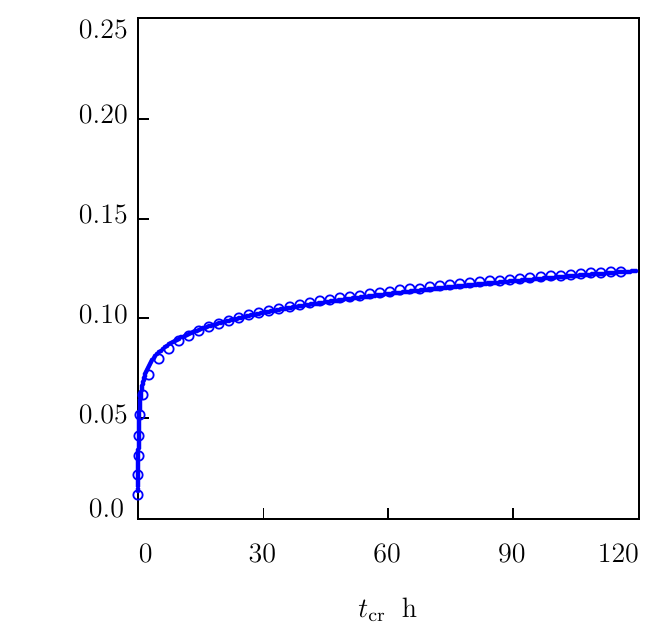
Figure 8. Tensile strain (cid:101) versus creep time t cr . Circles: experimental data in a creep test with tensile Figure 8: Tensile strain (cid:15) versus creep time t . Circles: experimental data in a creep test stress σ = 12.0 MPa. Solid line: predictions of the cr with tensile stress σ = 12 . 0 MPa. Solid line: predictions of the model.